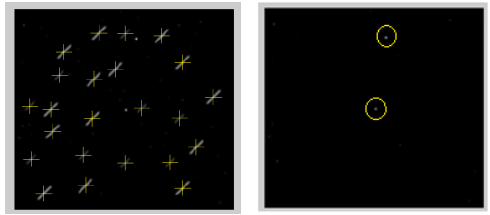
Figure 14. Because the image coordinates of stars in simulated data are known, the accuracy of the centroiding algorithm of star streaks can be calculated. The overall RMSE for the 23 streak is about 0.2 pixels. The result of star matching is better than 1 arc second.